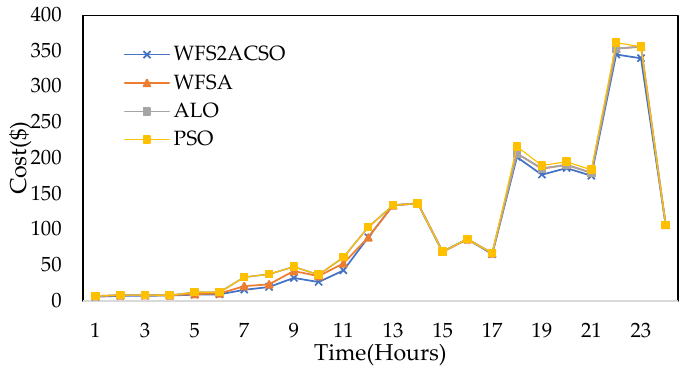
Figure 26. Cost comparison of various techniques for residential area.